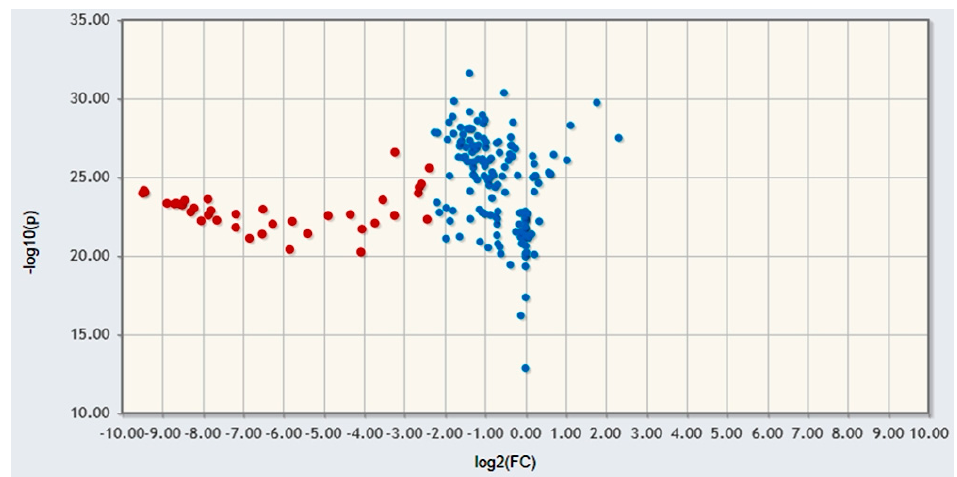
Figure 5. Volcano plot shows the logarithm of fold change (FC) obtained as the ratio from the peak intensities of the all of the protons in the 1 H spectra evaluated in treated vs. untreated HepG2 cells with respect to the logarithm of p -values by t -test analysis. Red symbols show the resulting protons that are statistically different between treated and untreated HepG2 cells by using, as threshold values, 2 for fold changes and 0.05 for p -values.